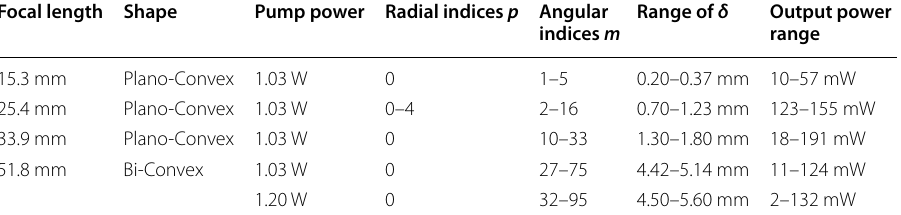
Table 1 The single LG mode operation achieved with different lenses (L2) Focal length Shape Pump power Radial indices p Angular